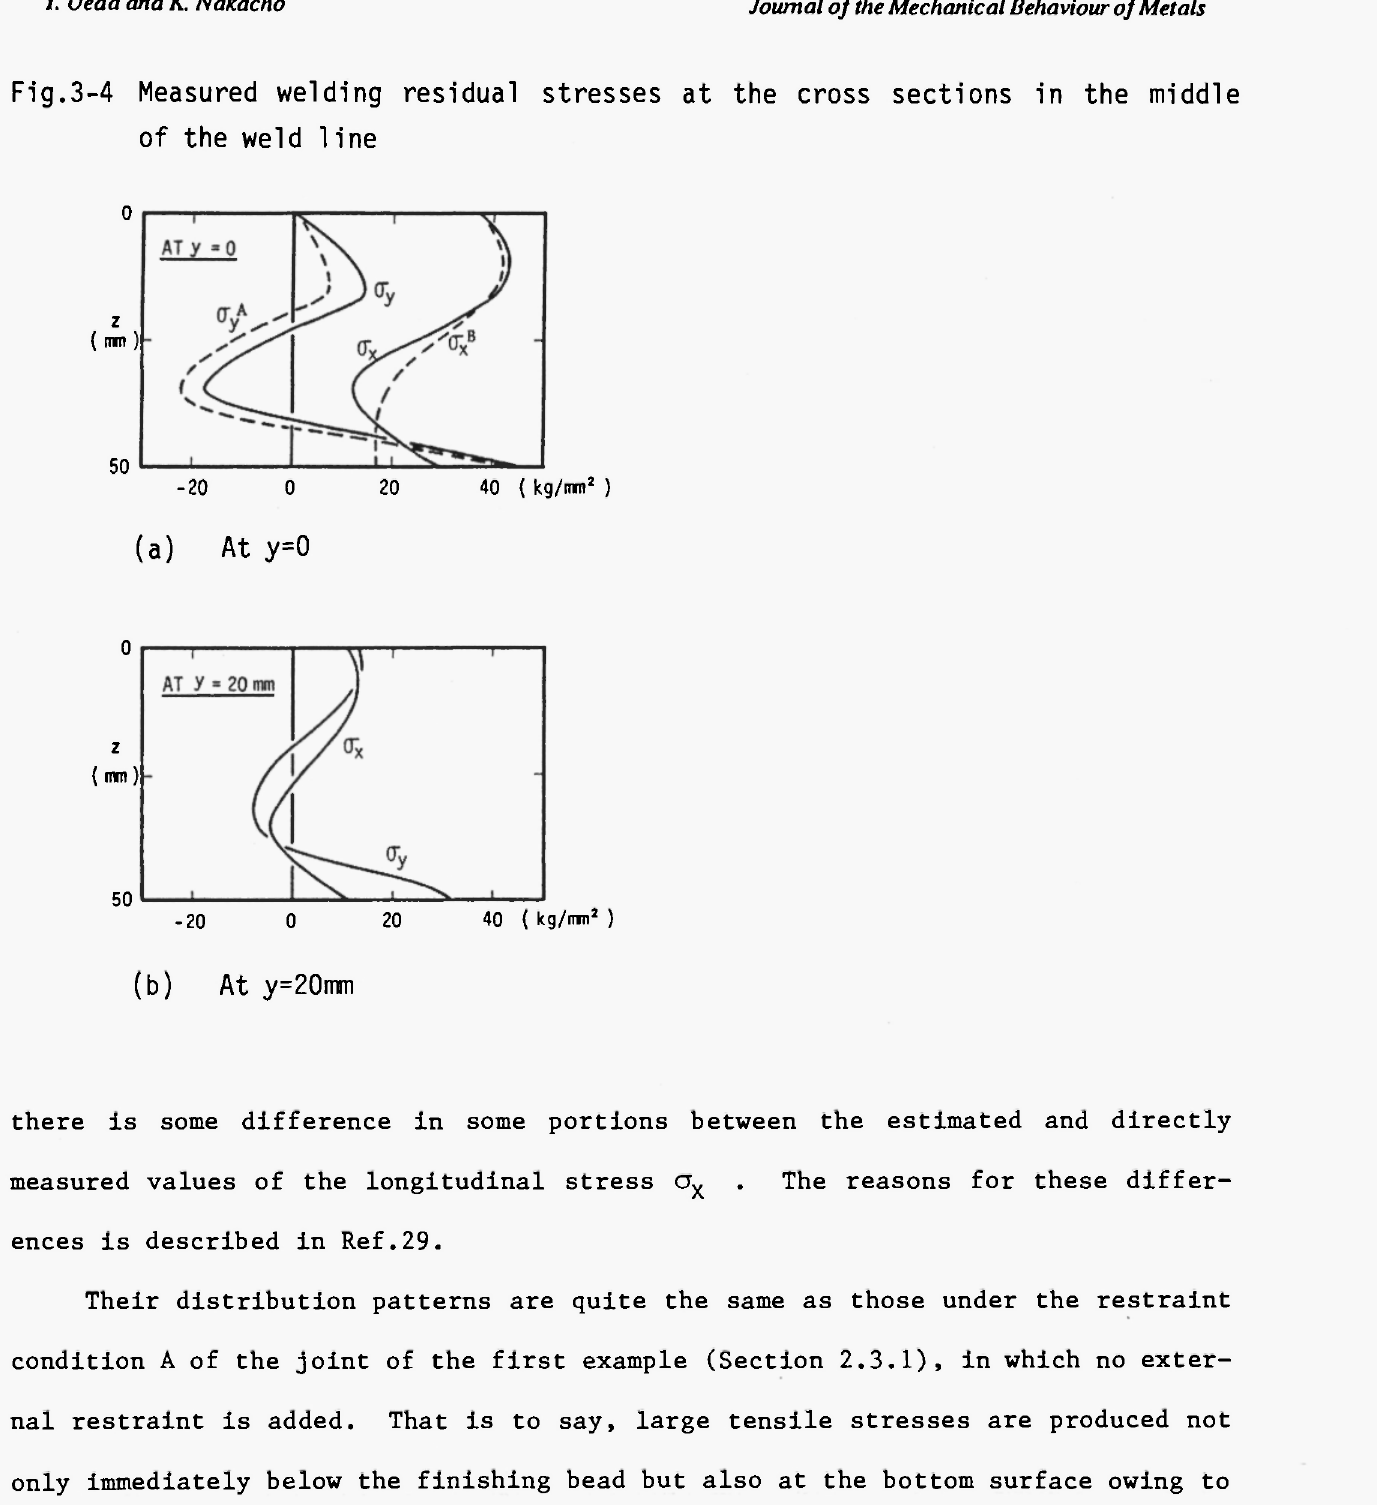
Fig.3-4 Measured welding residual stresses at the cross sections in the